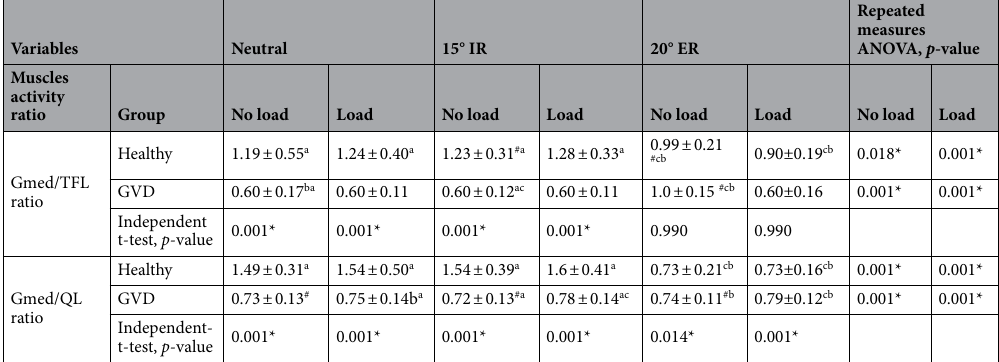
Table 3. Mean ± Standard deviation of muscles activity ratio during the pelvic drop in different positions of hip rotation with and without load (isometric hip external rotation). IR Internal rotation of hip position; ER External rotation of hip position. * p ≤ 0/05: Bonferroni post hoc test: a a significant difference with 20 0 external rotations, b a significant difference with 15 0 internal rotation, c a significant difference with neutral. # a significant difference between pre-and post-load intervention based on the paired